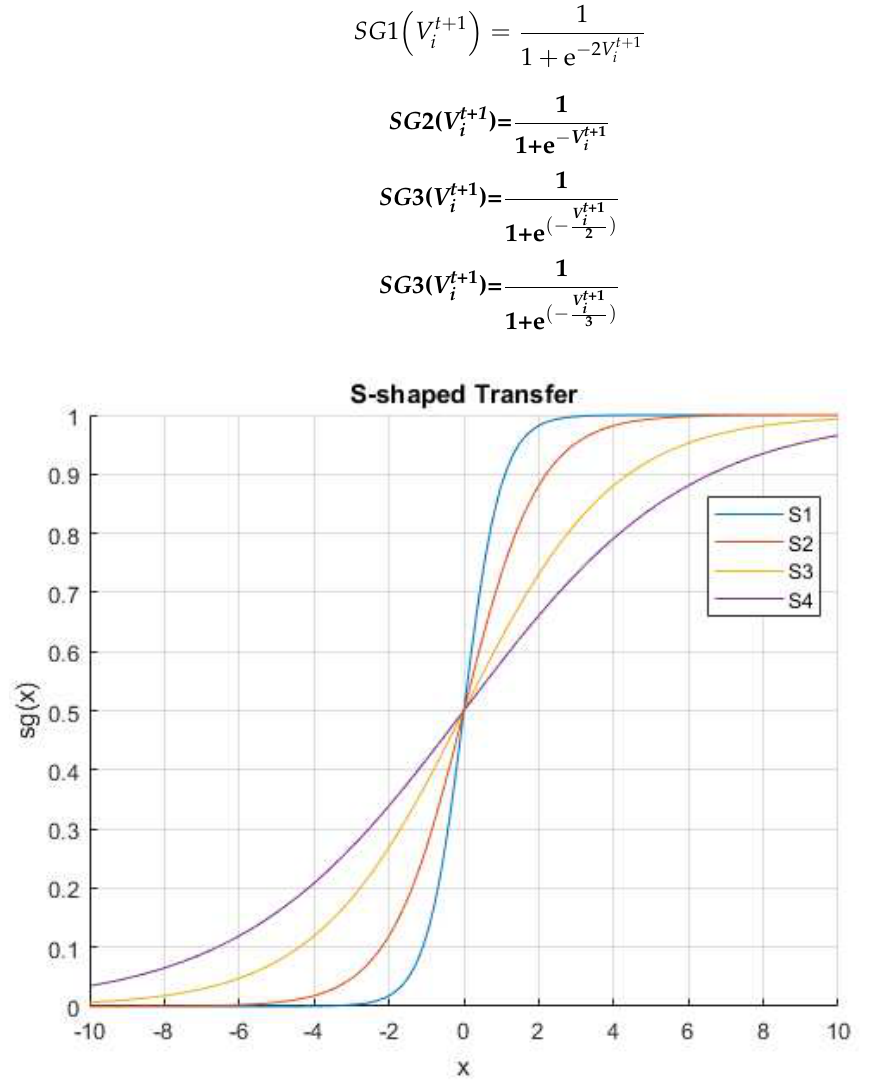
Figure 3. A graphic view of various types of S-shaped transfer function.